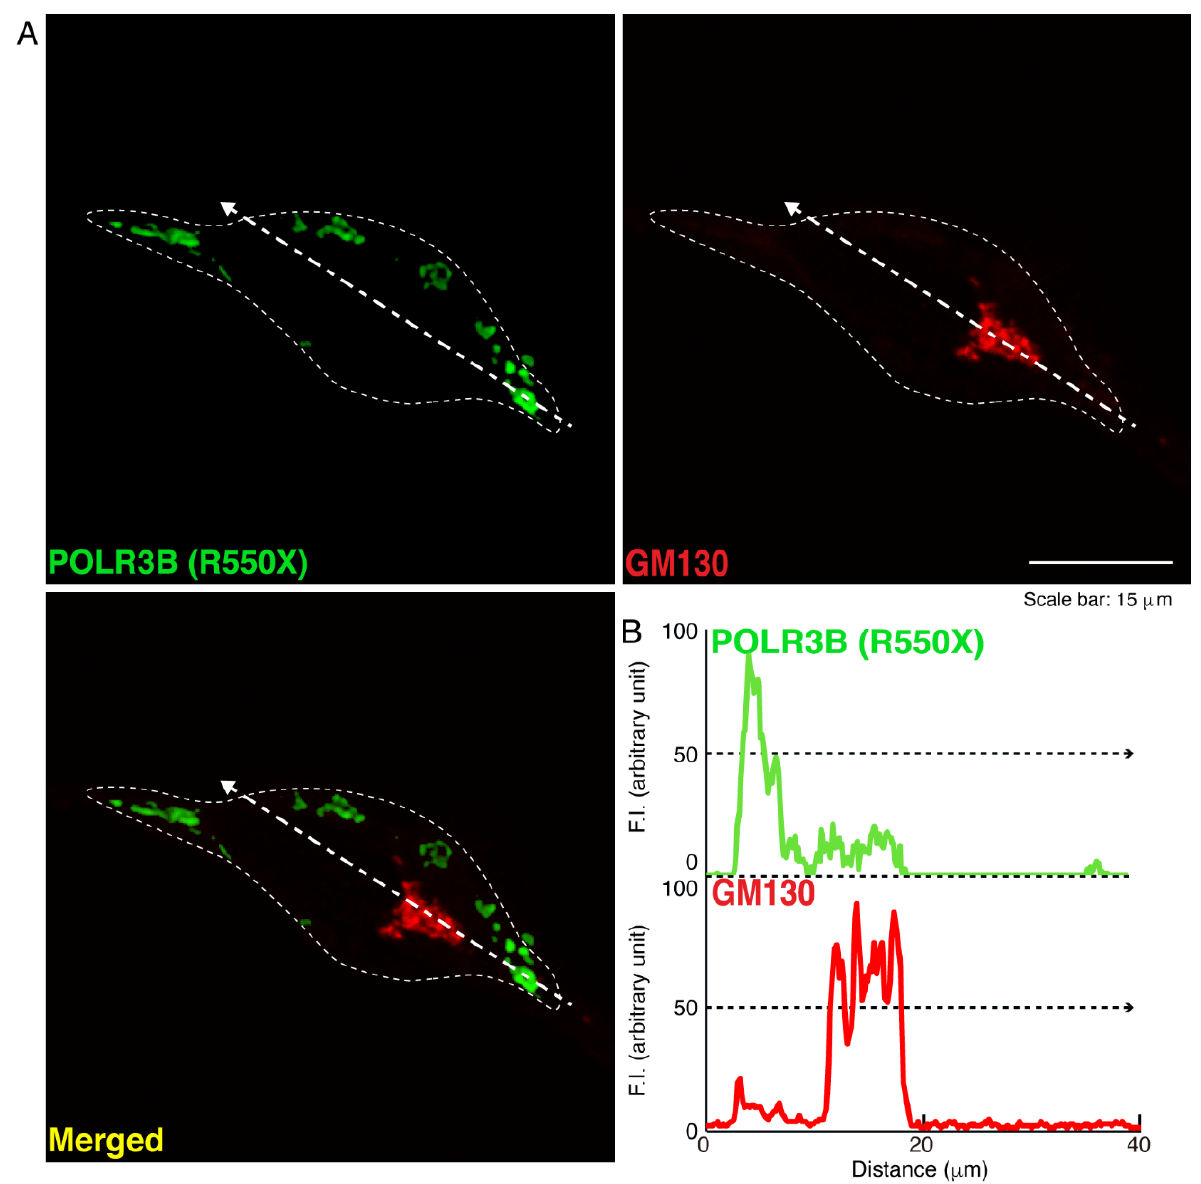
Figure 5. Mutated proteins are not co-localized with the Golgi body in cells. ( A , B ) Cells were transfected with the plasmid encoding POLR3B (R550X) (green) and stained using an antibody against the GM130 antigen (red). Scan plots were performed along the white dotted lines in the direction of the arrows in the color images (green and red as well as merged images). Graphs showing the fluorescence intensities (arbitrary units) along the white dotted lines in the direction of the arrows (black dotted lines in right bottom panels) can be seen in the right bottom panels.